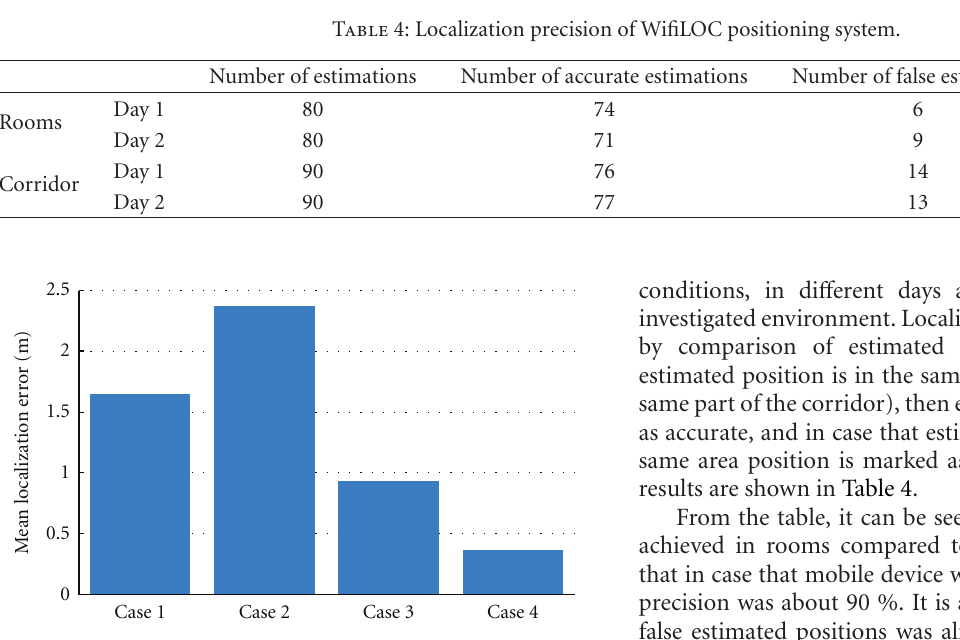
Figure 8: Localization error achieved in the di ff erent conditions in the indoor environment.